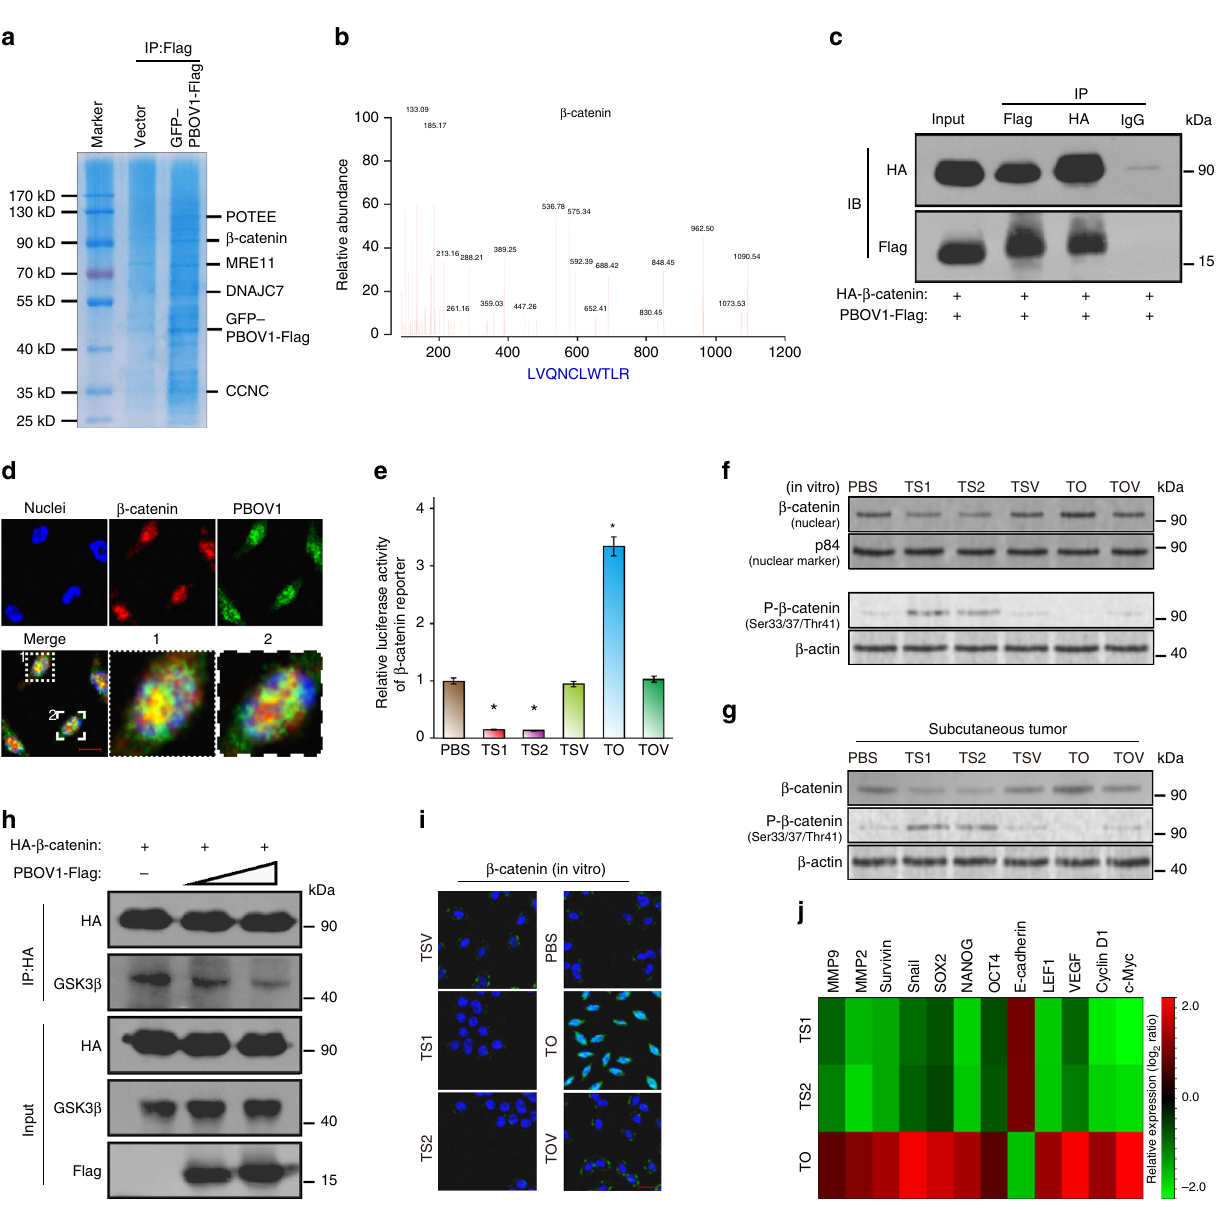
Fig. 7 PBOV1 binds to β -catenin and activates Wnt/ β -catenin signaling. a Representative picture of coomassie blue staining of proteins co- immunoprecipitated with PBOV1. b Representative MS plots and sequences of peptides from β -catenin. c Immunoprecipitation assay con fi rming interaction between PBOV1 and β -catenin. d Representative confocal images showing colocalization of PBOV1 and β -catenin (Scale bar, 10 μ m). e β -catenin luciferase- reporter activities analyzed in various groups of Hep3B cells. Data were represented as means ± S.D. Error bars represent the S.D. values ( n = 3; * P < 0.05. Signi fi cant differences were analyzed by Student ’ s t test, compared with PBS control group). f Protein expression levels of β -catenin in the nuclear fraction and Phospho- β -catenin (Ser33/37/Thr41) in Hep3B cells in vitro determined by western blotting assay. P84 and β -actin served as loading control. g Protein expression levels of total β -catenin and Phospho- β -Catenin (Ser33/37/Thr41) in Hep3B subcutaneous tumor tissues determined by western blotting assay. h PBOV1 attenuates interactions between β -catenin and GSK-3 β in dose-dependent manner. i Immuno fl uorescence staining of β -catenin in the indicated Hep3B cells. (Scale bar, 20 μ m; Blue, DAPI-indicating nuclei; green, FITC indicating β -catenin protein). j Real-time PCR analysis demonstrating an apparent overlap between β -catenin-dependent gene expression and PBOV1-regulated gene expression. The pseudocolour represents the intensity scale for indicated treatment groups versus PBS control group, calculated by log 2 transformation